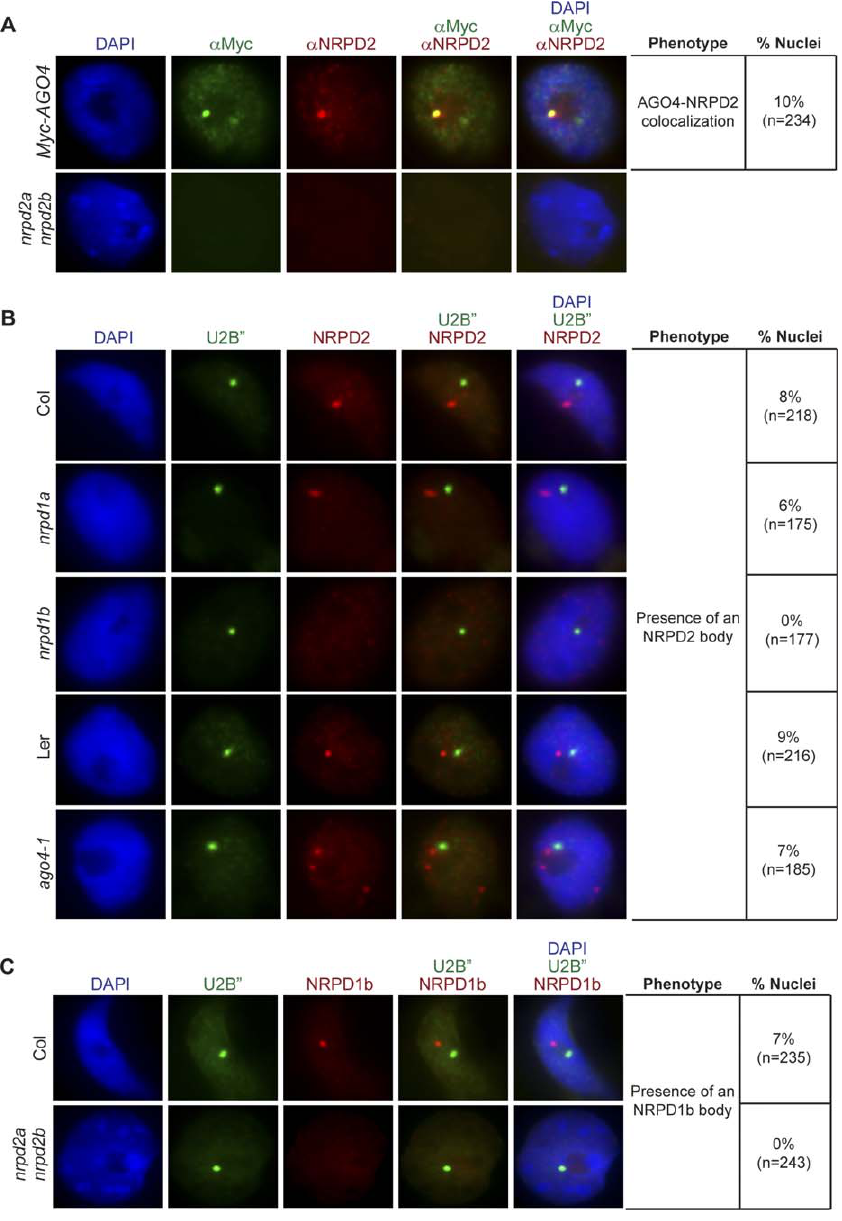
Figure 5. Localization of NRPD2 Relative to the AB-Body (A) Immunofluorescence analysis of NRPD2 localization relative to AGO4 in Myc-AGO4 nuclei. A polyclonal antibody was used to detect endogenous NRPD2 protein. (B) Localization of NRPD2 relative to U2B 99 in wild type, nrpd1a , nrpd1b , or ago4 mutant nuclei. Ler is the wild type control for ago4 within the same ecotype, and Col is the wild type control for nrpd1a and nrpd1b . (C) NRPD1b nuclear body formation in wild type versus nrpd2a nrpd2b . Nuclei were co-immunostained with an antibody to U2B 99 .